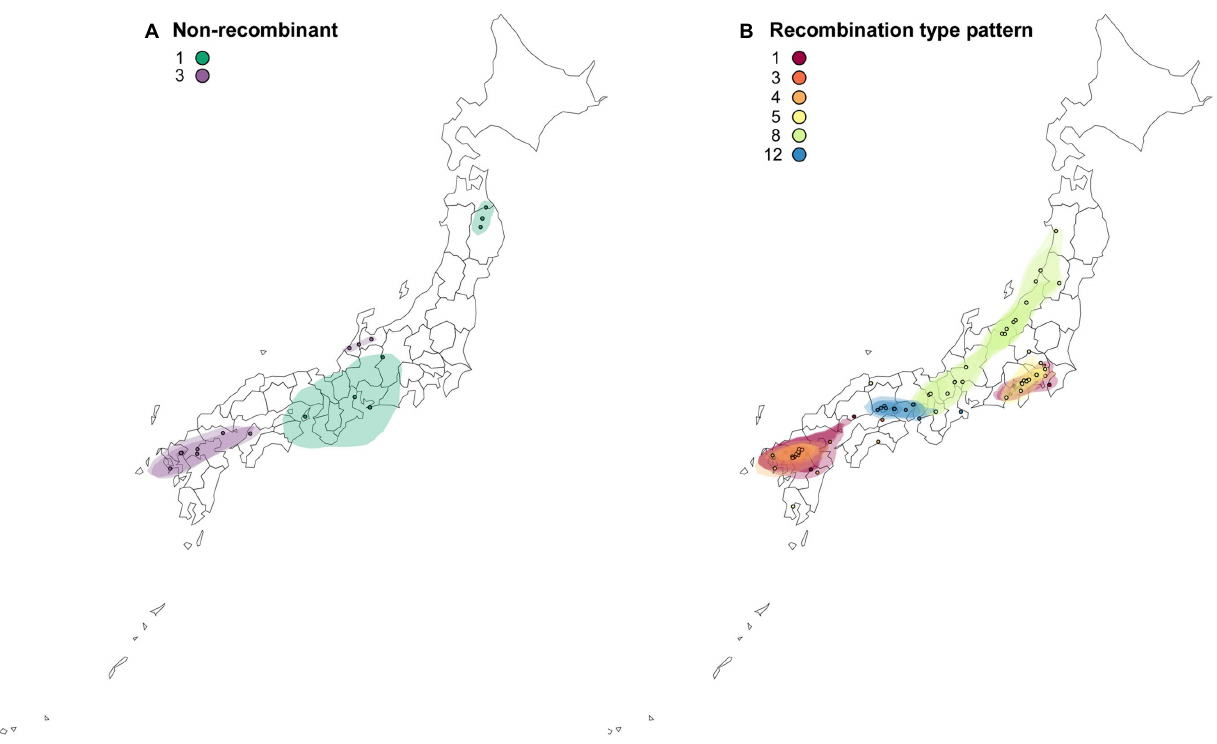
FIGURE 6 | Reconstructed spatial diffusion of ScaMV isolates in Japan for (A) non-recombinant and (B) recombinant isolates. The point indicated the location of ancestral internal nodes and external tips. The 95% CI regions based on 1,000 trees subsampled from the post-burn-in posterior distribution were shown as colored shadows. The map was obtained from